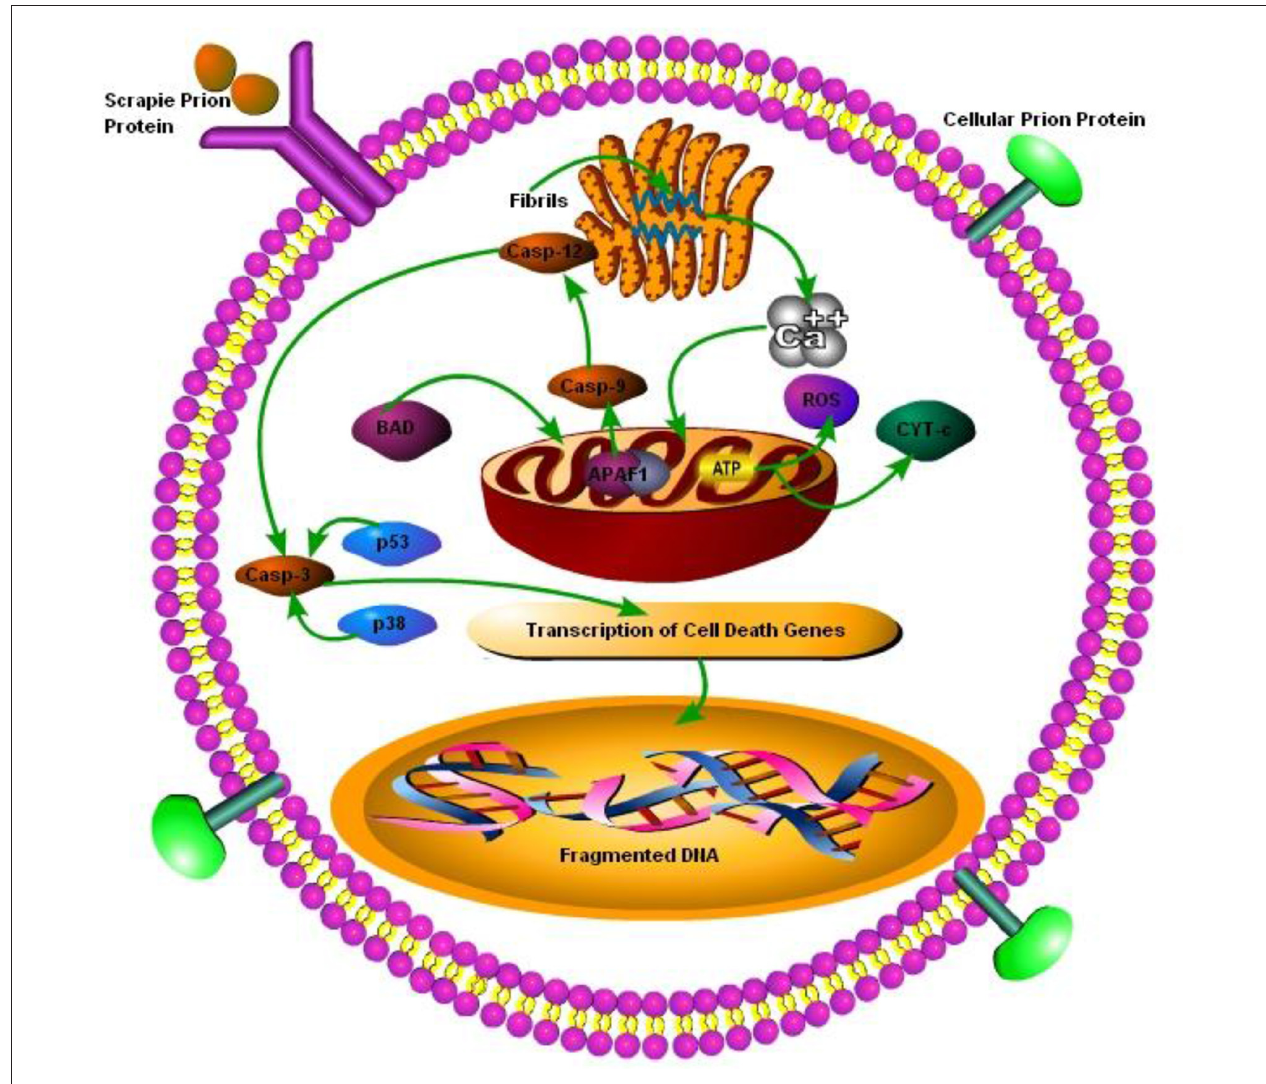
FIGURE 3 | Schematic presentation of cell death mechanisms in prion disease. The cellular PrP (PrP c ) is found on the cell membrane, upon change from PrP c to prion protein scrapie (PrP Sc ), it is internalized by cell membrane bound receptors and transported to ER for folding and processing. The accumulation of misfolded PrP Sc in ER leads to perturbations in calcium (Ca 2 + ) homeostasis, which ultimately leads to pro-apoptic BCL-2 associated death (BAD) translocation into mitochondria and release of cyctochrome-c and apoptotic activating factors from mitochondria, triggering caspase-dependent apoptotic signaling. Dysregulated Ca 2 + homeostasis results in reduced ATP production in mitochondria leading to reactive oxygen species (ROS) production. Under caspase-dependent apoptotic surge caspe-3 is degraded via p53 and p38 transcription factors leading to DNA fragmentation in nucleus of the cell (Ferreiro et al., 2006, 2008a,b; Uppington and Brown,